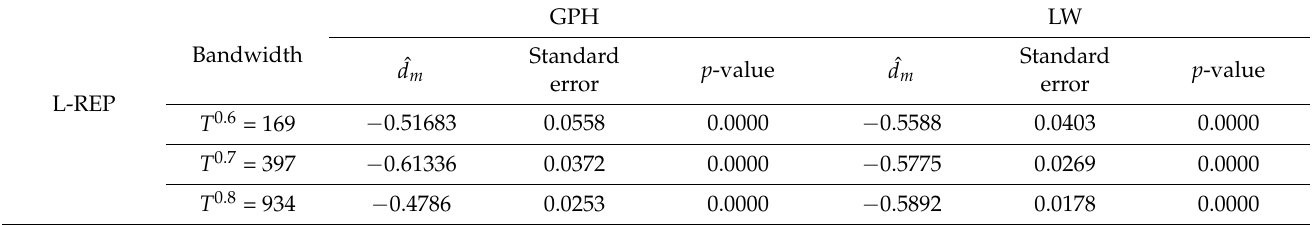
Table 2. Results of GPH and LW tests in the conditional mean.